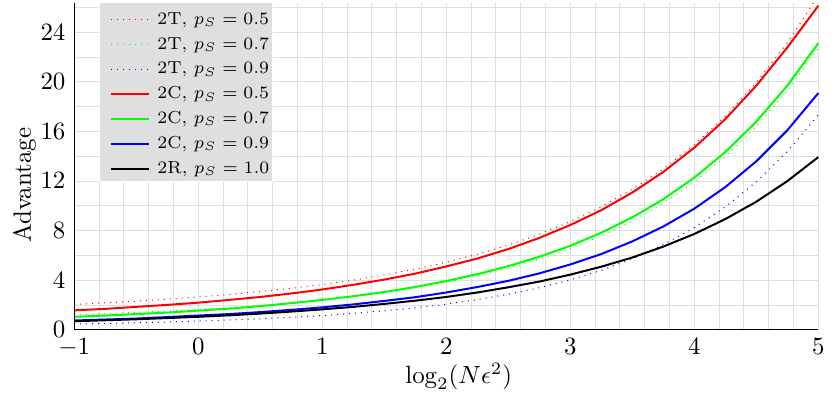
Figure 4: Theoretical advantages of Algorithms 2T, 2R, and